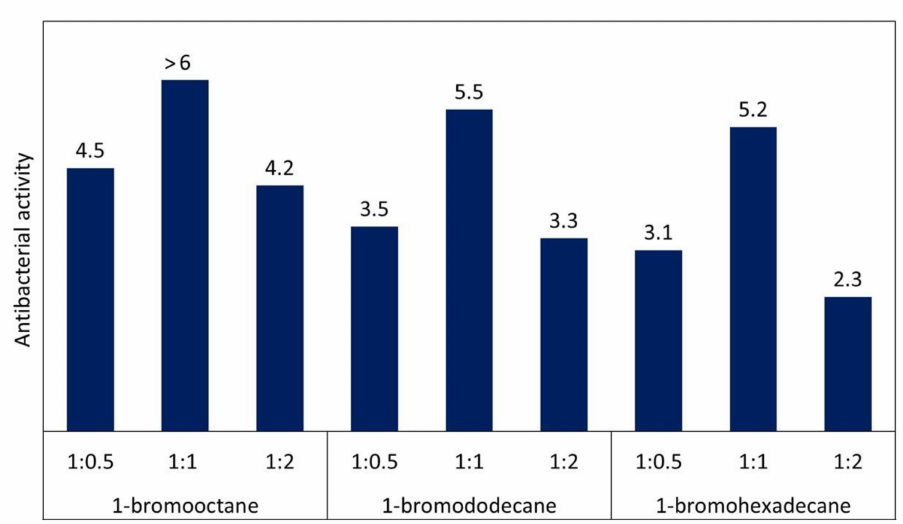
Figure 6. Antibacterial activity of QA-PEI nanoparticles alkylated with di ff erent N -alkylation agents and with various degrees of N -alkylation. Data from